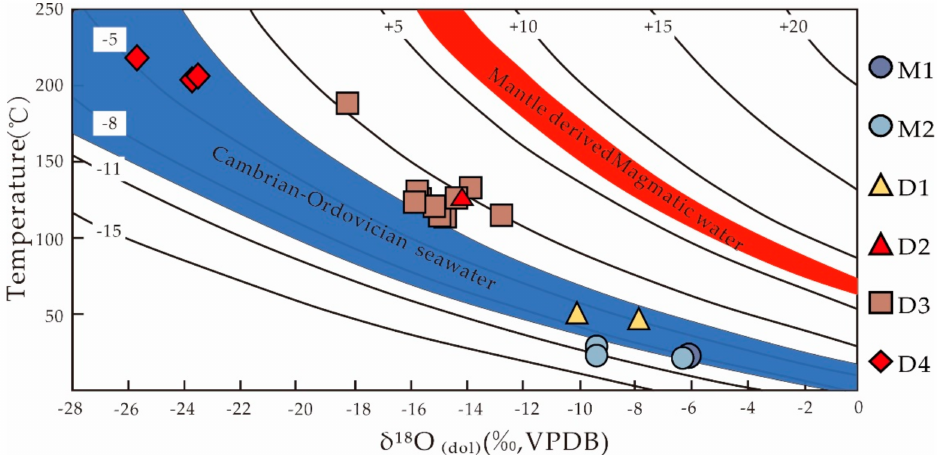
Figure 10. Crossplots of fluid inclusion homogenization temperature (Th) against oxygen signature for the matrix dolomite and various dolomite cements in the southwest of the Dongying Depression, Bohai Bay Basin. The data for mantle-derived magmatic water are quoted from [88]. M1: argilla- ceous dolomite; M2: microcrystalline dolomite; D1: powder-to-fine-crystalline dolomite cements; D2: fine-crystalline ferroan dolomite cements; D3: medium-to-coarse-crystalline dolomite